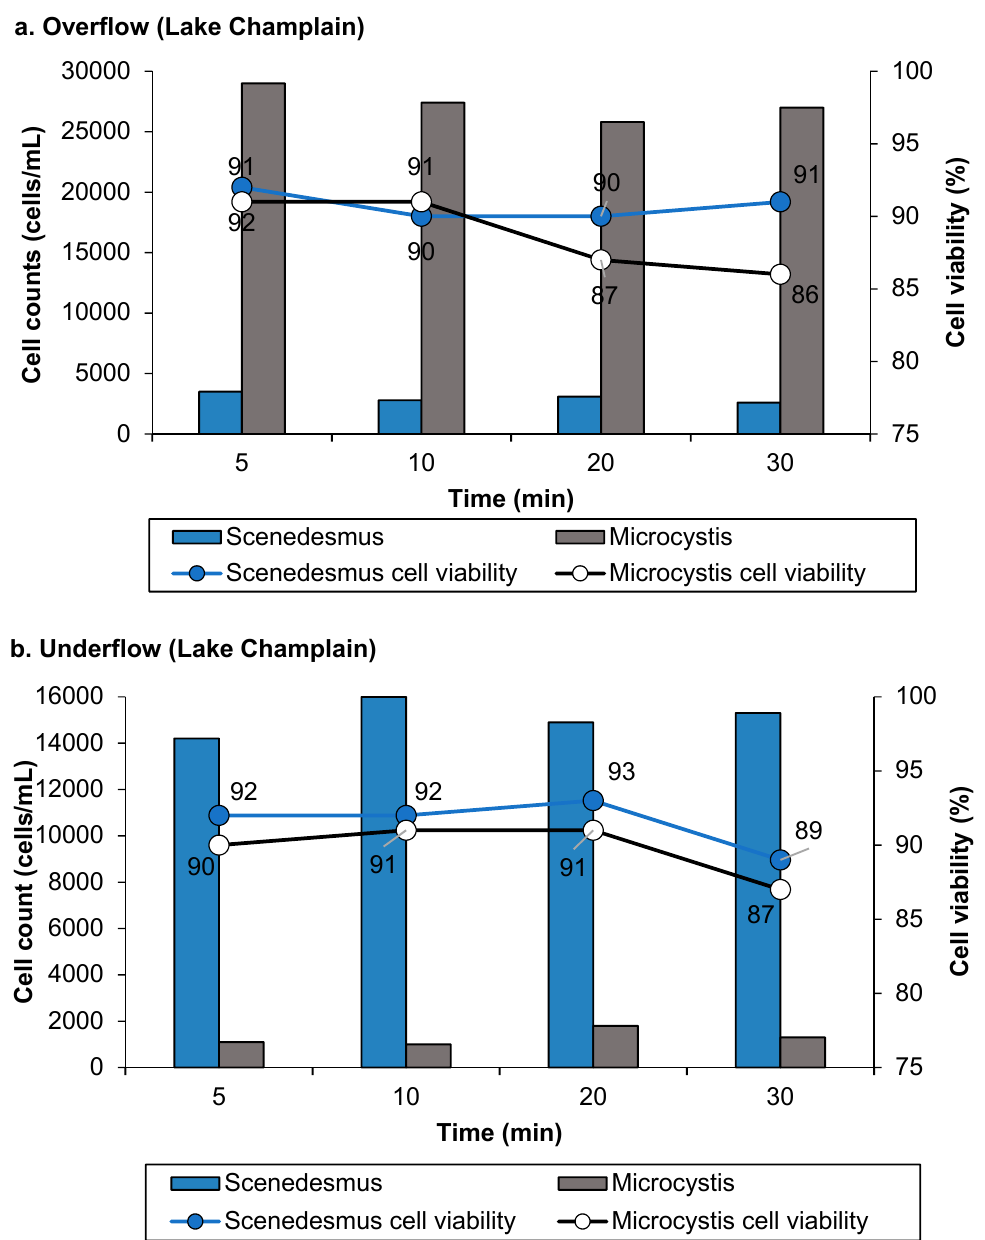
Figure 2. The concentration of Microcystis and Scenedesmus cells present (left axis) and the viability of those cells (right axis) over time when spiked into Lake Champlain water in the overflow ( a ) and underflow ( b ).